Question: Provide a one-line summary of what is displayed.
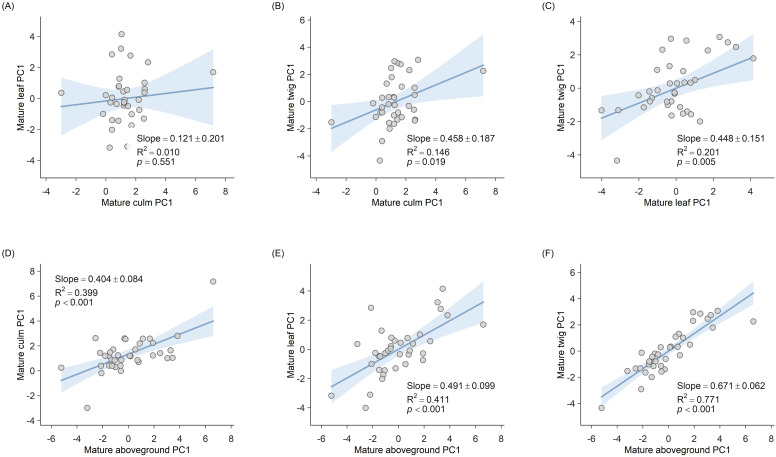
Answer: Scaling relationships of organ- and aboveground-level PC1 scores in mature Fargesia denudata . (A–C) Scaling relationships among culm, leaf, and twig PC1 scores. (D–F) Scaling relationships between organ-level PC1 scores and aboveground PC1 scores. Blue lines indicate fitted regression lines, and shaded areas represent 95% confidence intervals. Each point represents a plot mean.